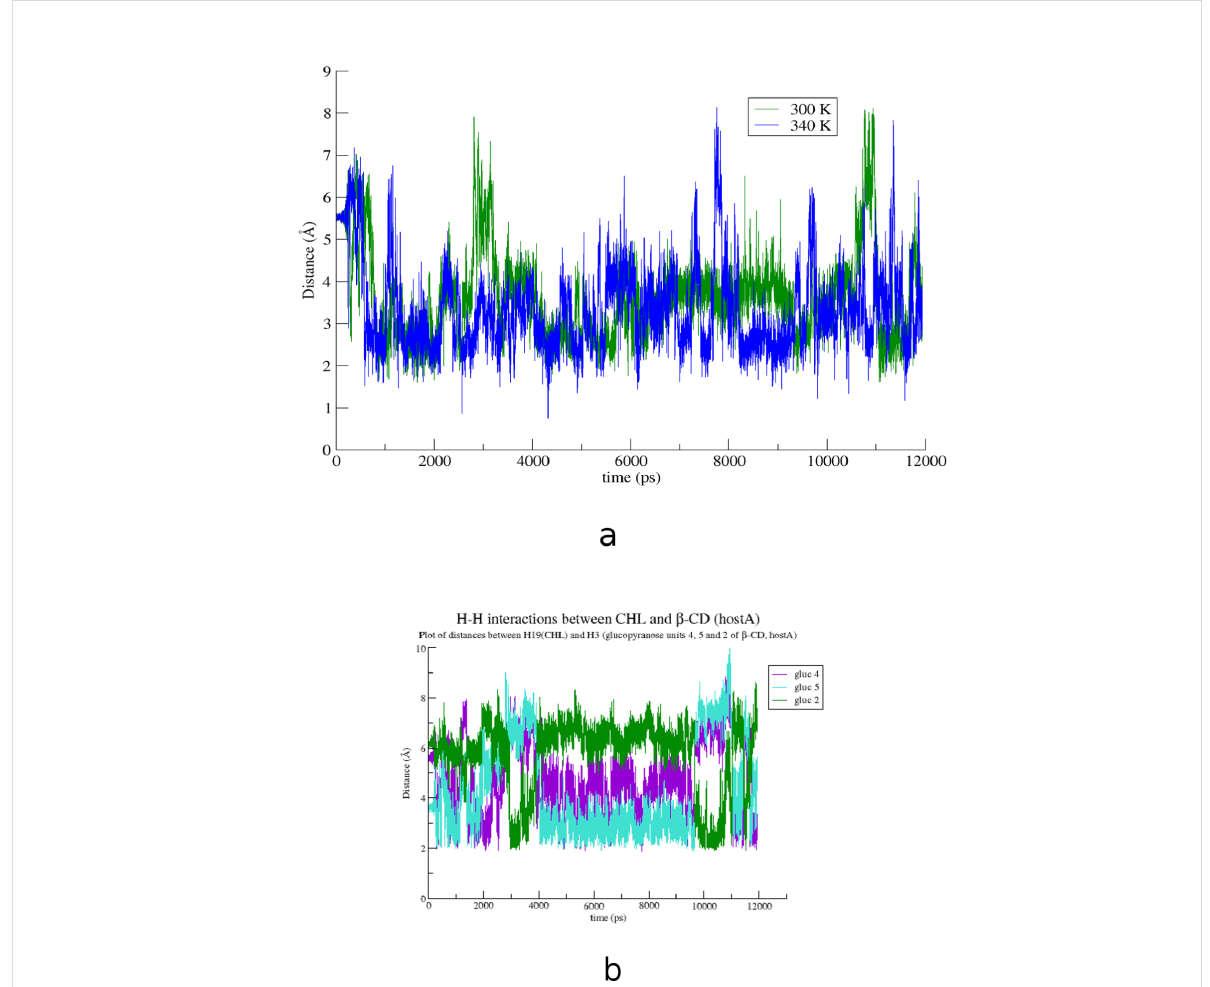
Figure 5: (a) Distance between the O1 atom (CHL) and the centroid D K of the O4 n atoms of host A at 300 (green) and 340 K (blue) and (b) distances between Η 19 atom of CHL (ring A) and H3 atoms of the 4th (purple), 5th (cyan) and 2nd (green) glucopyranose units of host A.